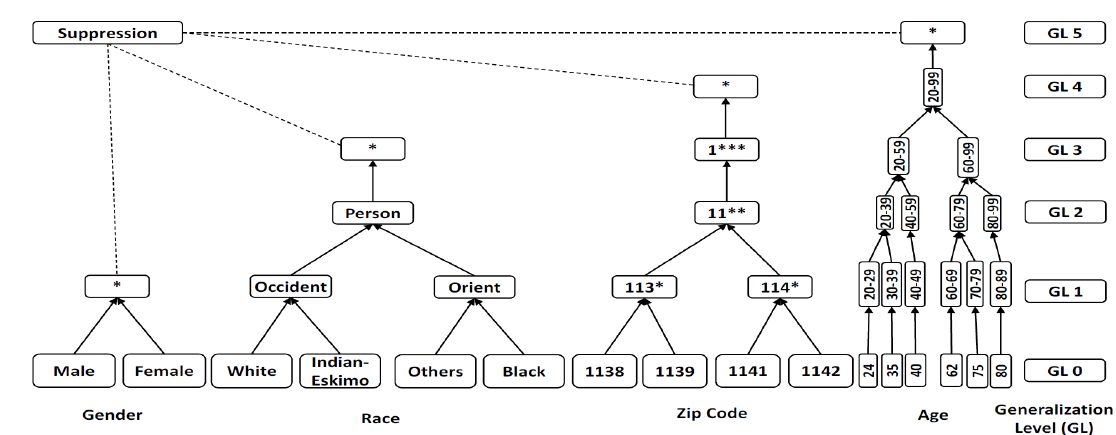
Figure 2. Examples of Generalization and Suppression for a Domain Generalization Hierarchies ( DGH ).